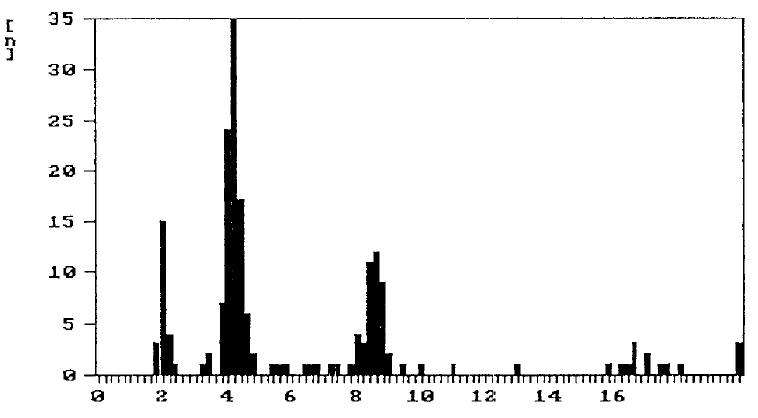
Fig. 5. DNA-histogram of brush-harvested carcinoma in situ cells (Fig. 2) reveals DNA-aneuploidy as evidence of malignancy (abnormal stem- lines at 4.4c and 8.8c and 17 cells > 9c).